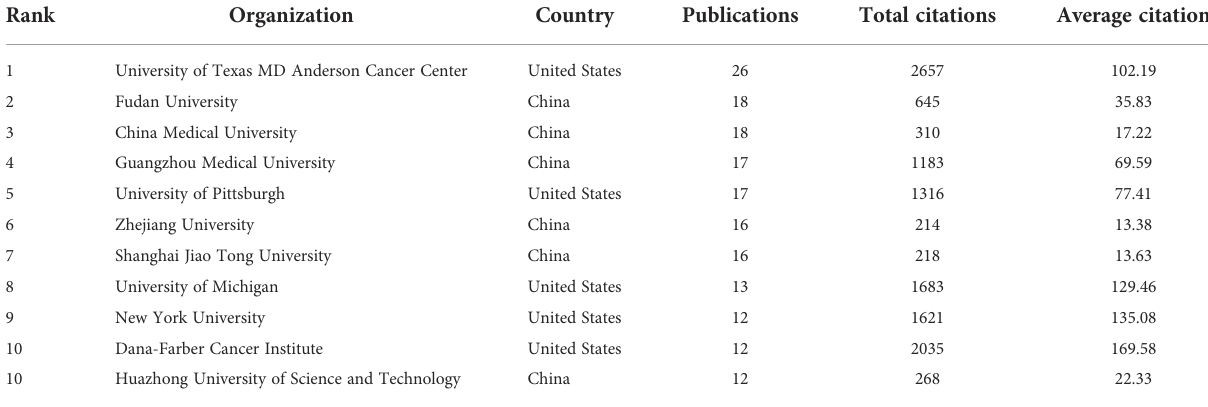
TABLE 2 The top 11 productive organizations published literature related to autophagy of pancreatic cancer. Rank Organization